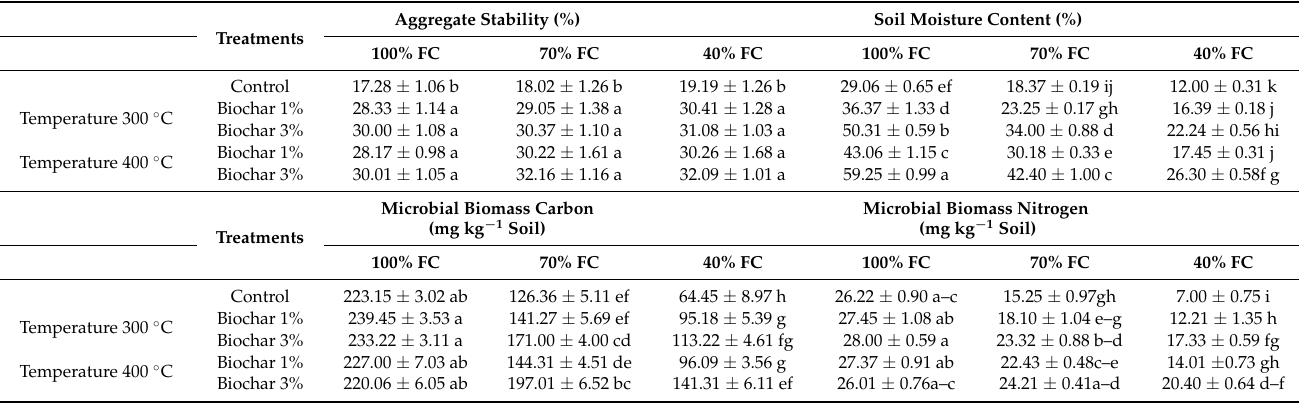
Table 4. The effect of biochar on aggregate stability, soil moisture content, soil microbial carbon and nitrogen under drought